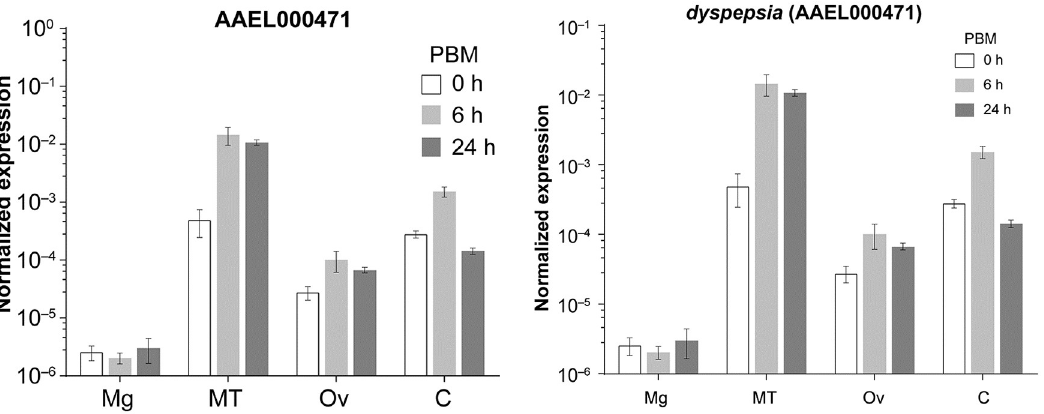
Fig 7. Organ-specific transcript expression of dysp (AAEL000471) pre- and post-bloodfeeding. qRT-PCR quantification of mRNA expression in the midgut (Mg), Malpighian tubules (MT), Ovaries (Ov) and remaining body parts (C). Transcript abundance is normalized to the housekeeping gene (rpS7). PBM: post-bloodmeal. The graph shows mean ± SD.